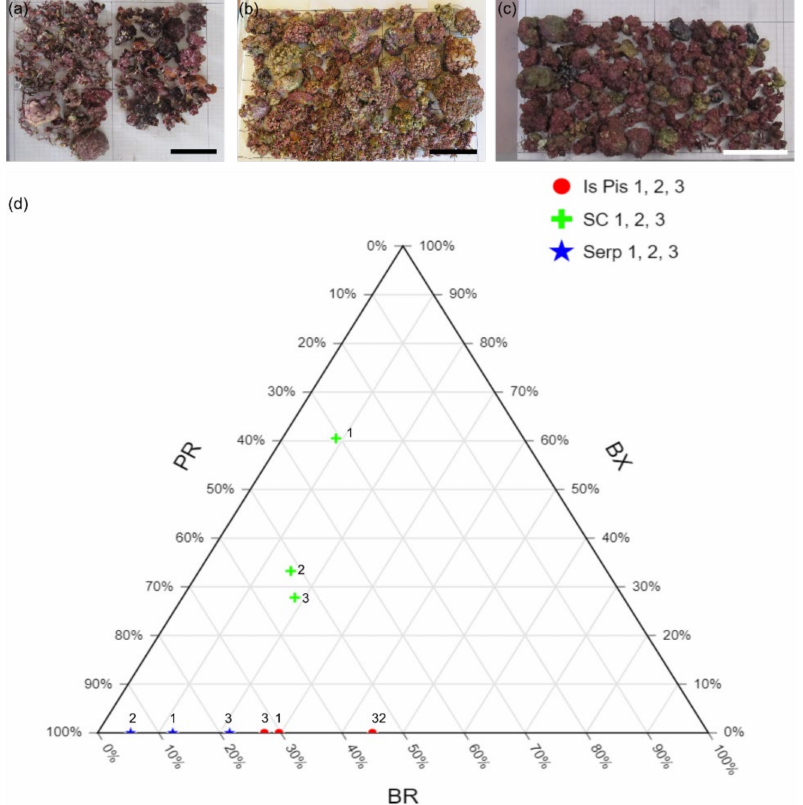
Figure 3. ( a ) Is Piscadeddus 1, ( b ) Santa Caterina 2, and ( c ) Serpentara 3 replicas of live rhodoliths. Scale bar indicates 5 cm. ( d ) ternary plot of the three main morphotypes (coverage in %) per site. Is Pis is for Is Piscadeddus, SC is for Santa Caterina, and Serp is for